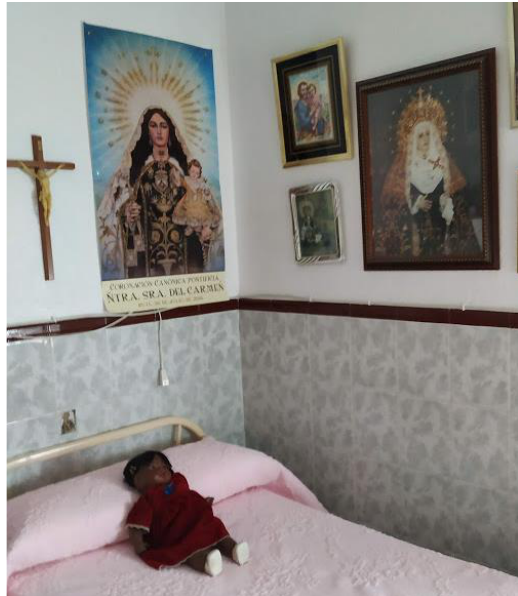
Photograph 4: A homemade decoration of the Virgin Mary on the wall in a care home bedroom.